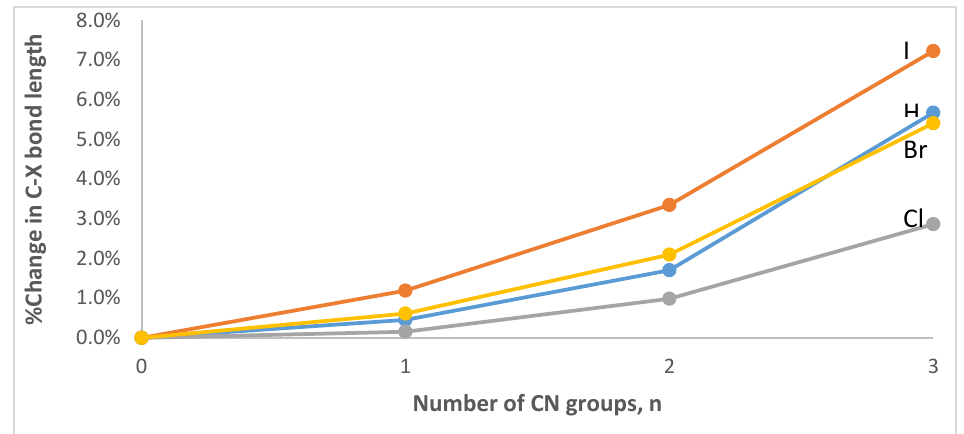
Figure 3. Percent change in the covalent C-X bond as a function of the number of CN groups in the CH 3-n (CN) n X∙∙∙NMe 3 (X = H, Cl, Br, or I; n = 0–3) complexes optimized at the ωB97X-D/aug-cc-pVTZ level of theory.